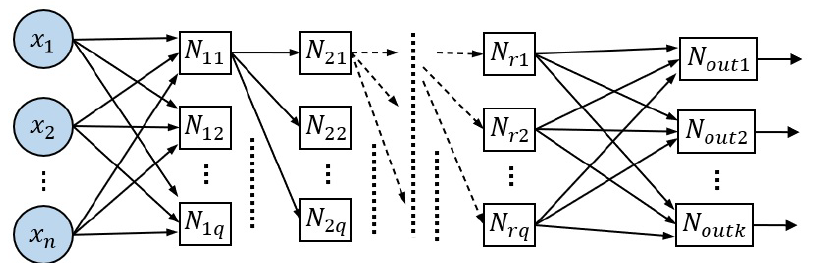
Figure 4. ANN with r hidden layers containing an equal number of neurons and k output neurons.